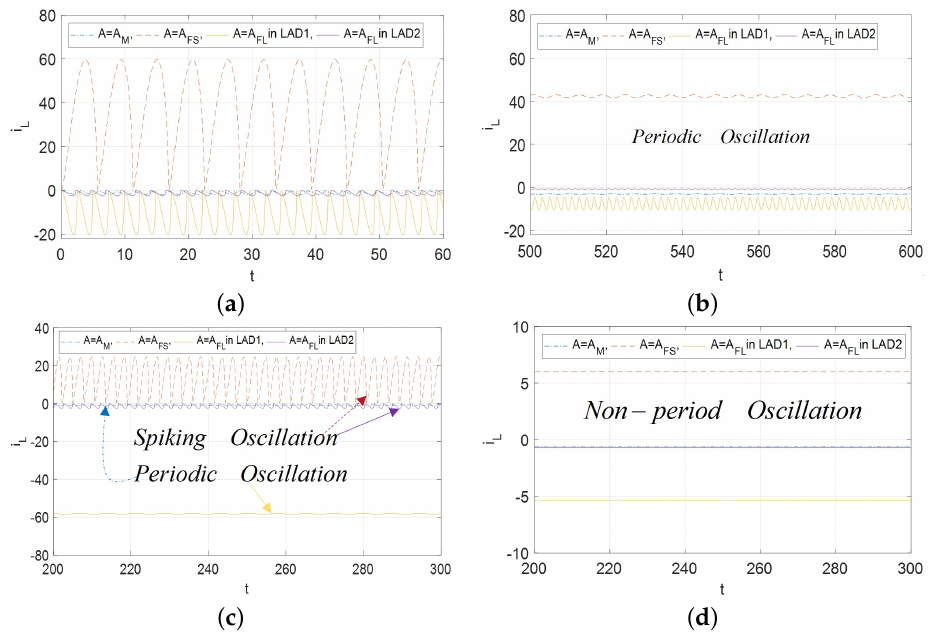
Figure 21. The oscillation behaviors: ( a ) Non-sinusoidal periodic waveforms at v = − 1.65 V for A = A M in LAD is drawn by blue dotted solid line, at v = 5.62 V for A = A FS in LAD is drawn by red dotted line, at v = − 1.62 V for A = A FL in LAD1 is drawn by yellow solid line, at v = − 13.1 V for A = A FL in LAD2 is drawn by purple solid line; ( b ) Periodic oscillation waveforms v = − 1.48 V for A = A M in LAD is drawn by blue dotted solid line, v = 3.55 V for A = A FS in LAD is drawn by red dotted line, v = − 1.62 V for A = A FL in LAD1 is drawn by yellow solid line, v = − 13.045 V for A = A FL in LAD2 is drawn by purple solid line; ( c ) Multiplex-oscillator waveforms v = − 2.39 V for A = A M in LAD is drawn by blue dotted solid line, v = 5.4 V for A = A FS in LAD is drawn by red dotted line, v = − 2.145 V for A = A FL in LAD1 is drawn by yellow solid line, v = − 13.4 V for A = A FL in LAD2 is drawn by purple solid line; ( d ) Non-periodic oscillation waveforms v = − 2.5 V for A = A M in LAD is drawn by blue dotted solid line, v = 6.0 V for A = A FS in LAD is drawn by red dotted line, v = − 2.2 V for A = A FL in LAD1 is drawn by yellow solid line, v = − 12.3 V for A = A FL in LAD2 is drawn by purple solid